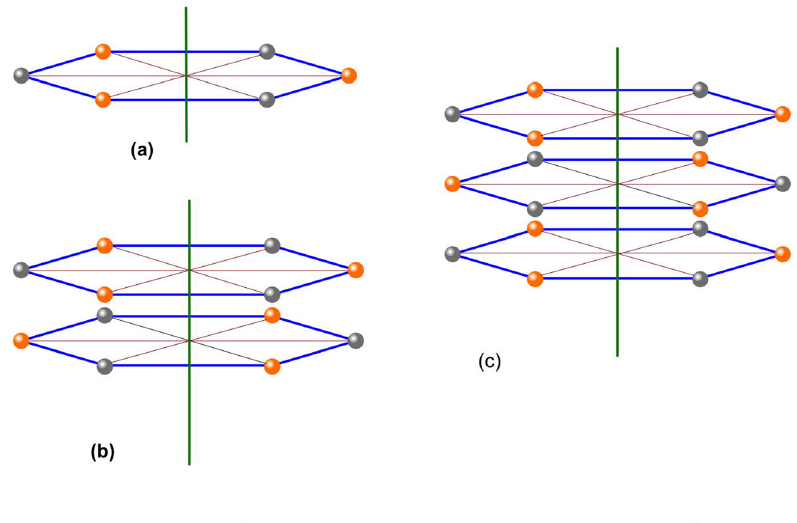
Figure 5: (Left): Plot of the three dimensional atomic arrangement of hBN. Boron atoms are plotted as yellow spheres and nitrogen atomsasblueones.Thevectorsofthelattice unit cell are represented using dashed red lines and the vectors of the reciprocal lattice are plotted as dashed purple lines. The vectors of the International basis (x,y) and (kx, ky) are also indicated. (Right) Plot of the Brillouin zone (green) with notations of specific points. Courtesy Dr. Thi Quynh Phuong